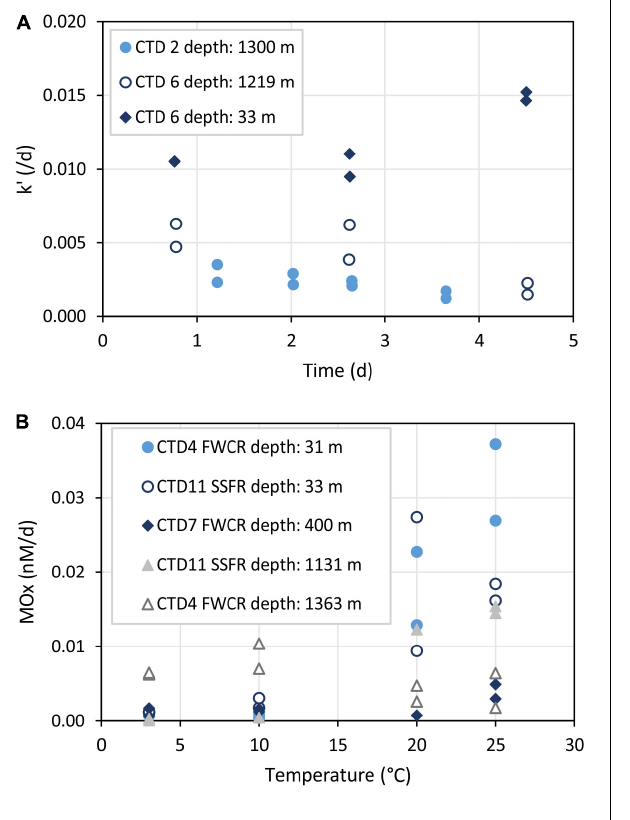
FIGURE 7 | Time series (A) and temperature incubations (B) of water from different depths. k’ refers to the relative activity of methanotrophic microorganisms and MOx to the aerobic methane oxidation rate. (A) Shows that k’ remains constant up to 3 days. (B) Illustrates increased MOx at temperatures > 20 ◦ C especially in surface water samples (CTD-4 FWCR depth: 31 m and CTD-11 SSFR depth: 33